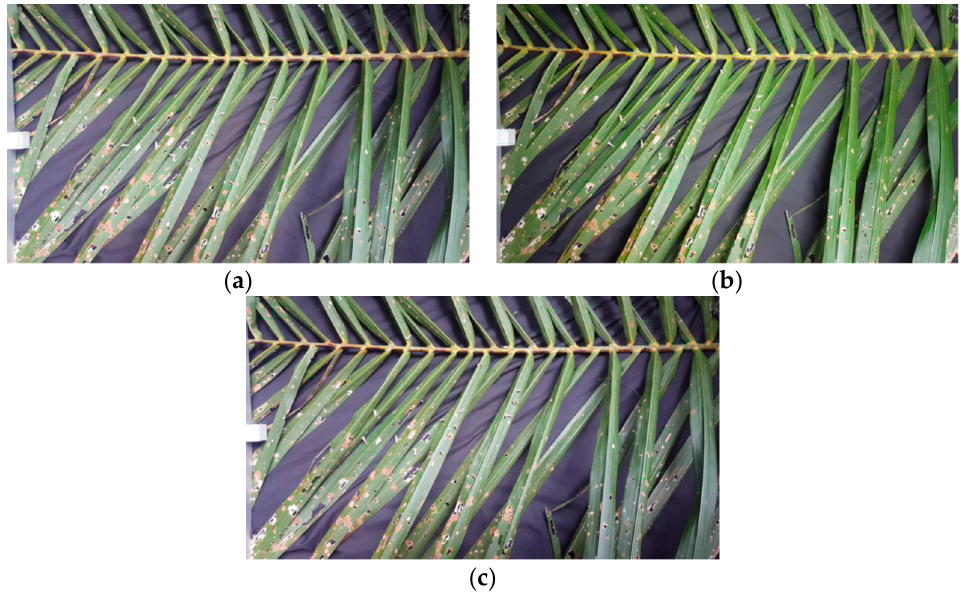
Figure 10. Detection based on 50 cm camera distance with: ( a ) open, ( b ) closed and ( c ) half-open areas.